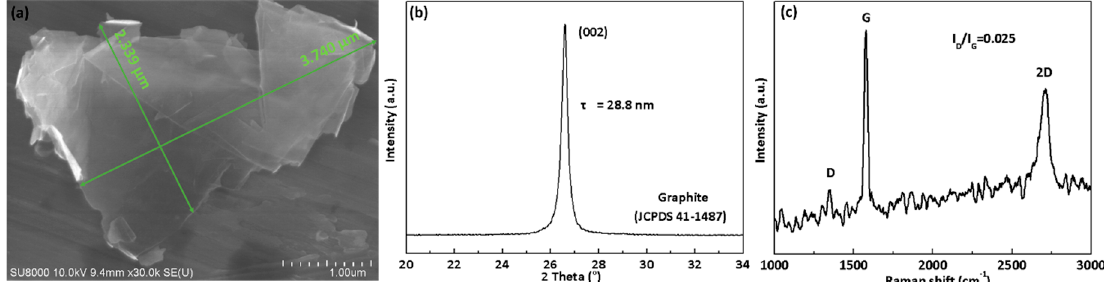
Figure 3. ( a ) Scanning electron microscopy (SEM) images of the as-received graphene flakes after